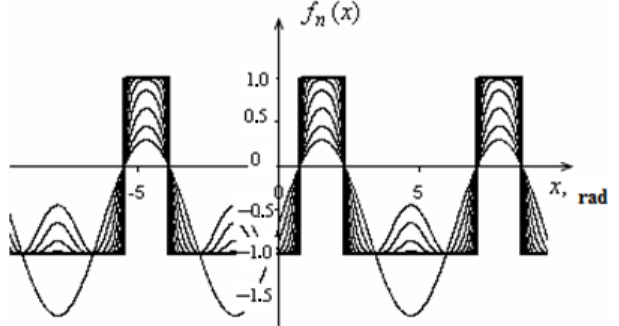
Figure 12. Approximation of a periodic step function with different length of intervals of the sine constant of the function.